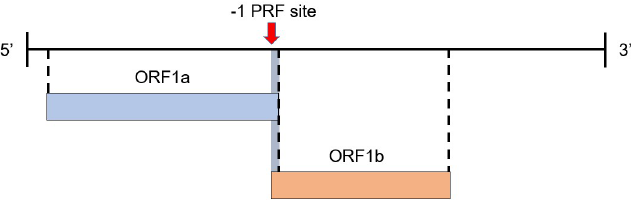
Fig 1. SARS-CoV-2 viral genome. − 1 PRF site marked by the red arrow. Normally, ribosome translates the complete ORF1a. Sometimes at the − 1 PRF site, ribosome shifts from ORF1a to ORF1b, resulting in synthesis of fusion ORF1a/ 1b